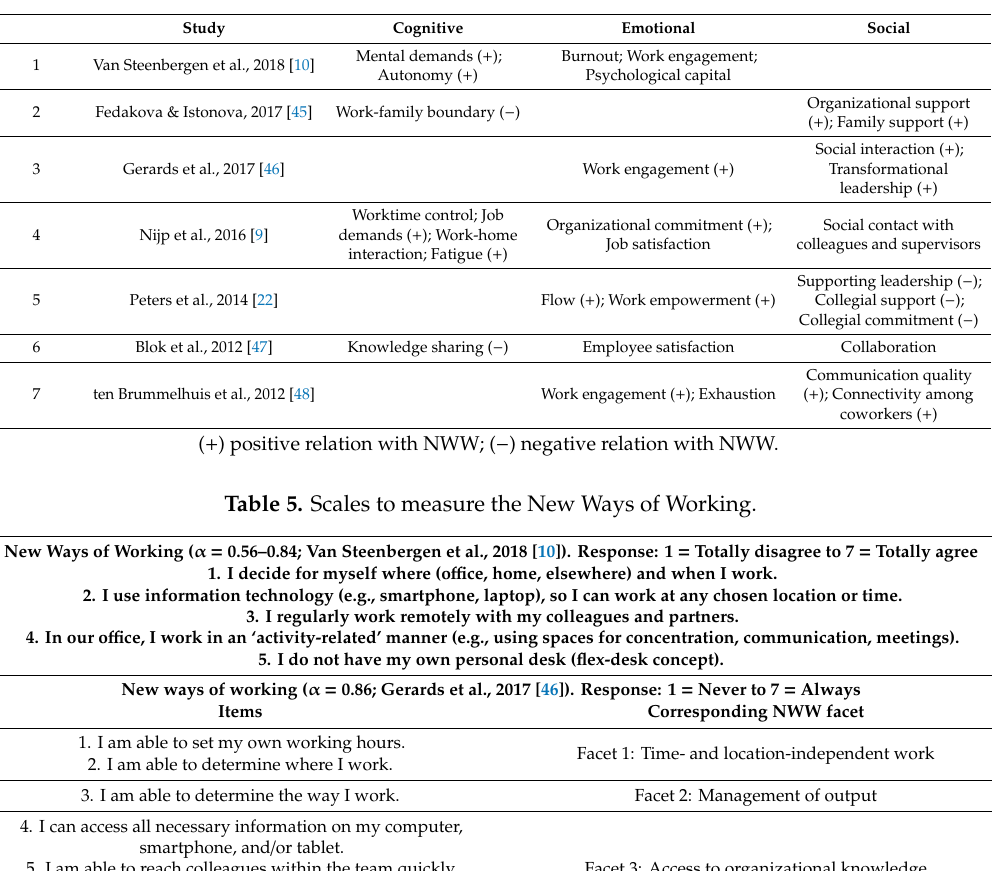
Table 4. Outcomes explored in the included studies.